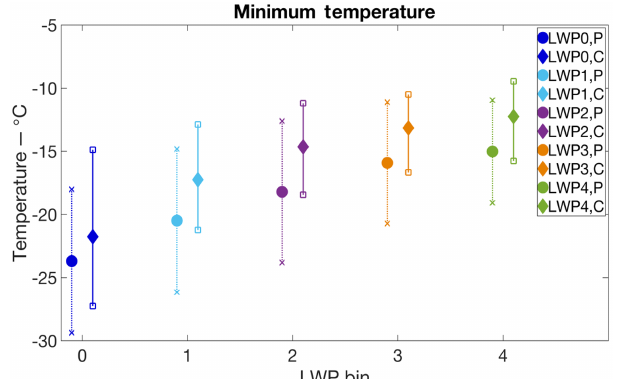
Figure 5. Mean minimum cloud temperature for clean and polluted clouds for each LWP bin. Diamond markers with solid line indi- cate clean clouds; circle markers with dashed line represent polluted cases. The bars span the 20–80th percentile of the T min distribution for each bin.